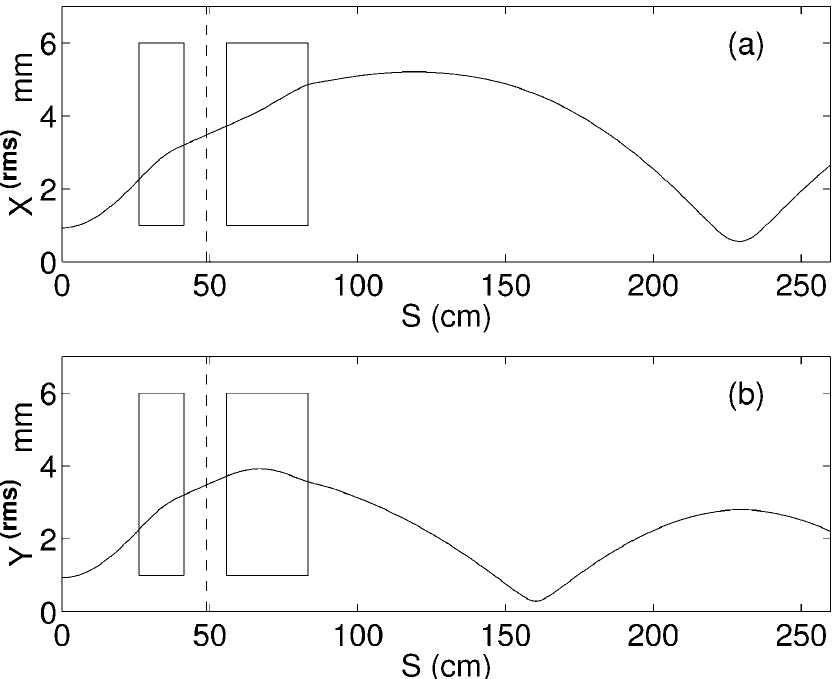
FIG. 3. The rms half-width of the profile predicted by the simulation for a Maxwellian electron beam in the experimental transport line for (a) the x - s plane and (b) the y - s plane. The transition from f (cid:1) 0 to f (cid:1) 1 is shown by the vertical dashed line. Boxes mark the relative s positions of the solenoid and dipole/quadrupole